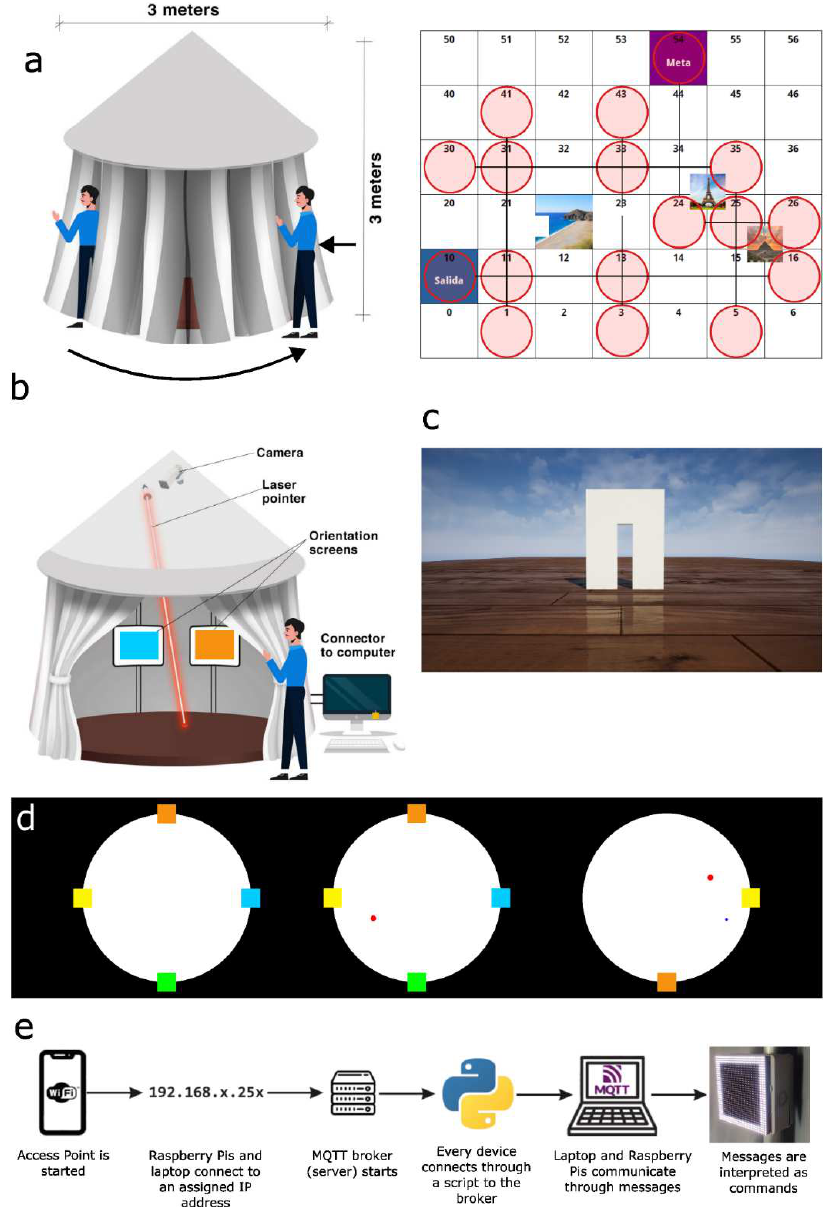
Figure 1. Overview of the spatial navigation tests. ( a ) Scheme of the maze test in the multi-test circular arena designed and built for this work. Note that the same arena has been used for both real-space hidden goal test and the multiple-choice maze-like task ( a , b ). To the left, exterior appearance of the tent showing how participants have to enter, exit, and go around. To the right, the map designed to implement the multiple-choice maze-like task. It is represented with North at the upper side of the scheme. Note that several paths can be chosen at some of the points, some cul-de-sacs exist, and the movements chosen do not necessarily lead to a linear displacement. The small pictures represent the few spatial cues that appear in the wall screens when the participant enters at the appropriate locations in the map. For example, the Eiffel tower is visible from locations 24, 25, and 35 on the screen that is at the appropriate direction (northeast, northwest, and southwest, respectively). There is only one circular arena, each time participants exit, they must reenter the arena by the opposite entrance the test ends when participants arrive at position 54. ( b ) Real-space hidden goal task, the tent is represented with open curtains to see 2 of the 4 screens of the wall and the roof devices. The aim of this test is to remember the laser position on the floor respectively to the position of the cues in the screens. ( c ) Screenshot of the program built in our lab to implement the virtual path